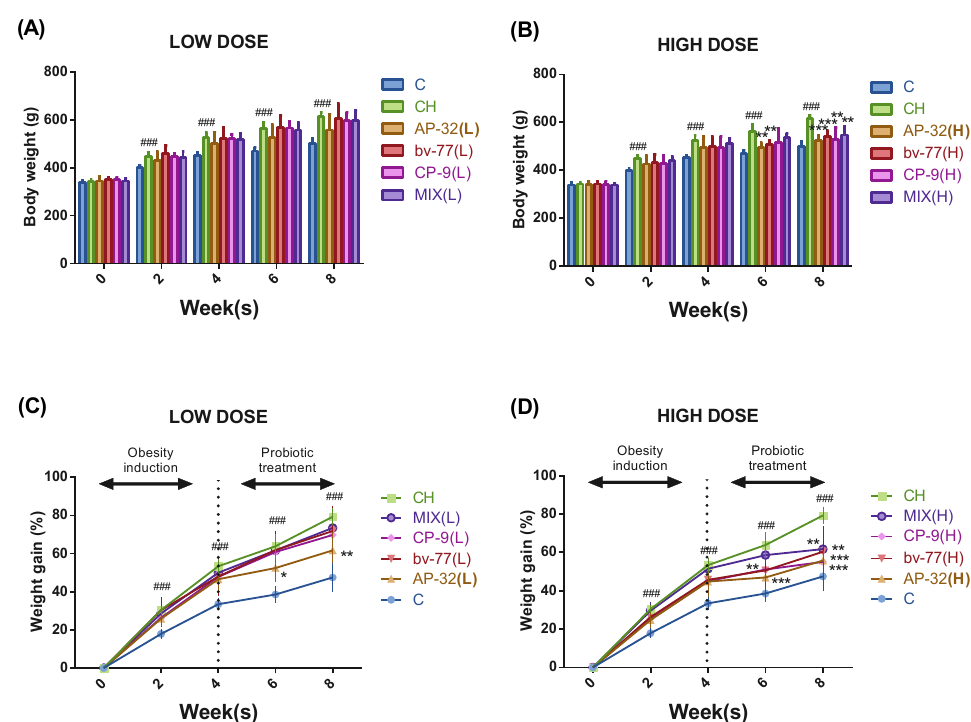
Figure 1. Body weights and weight gain rates in obese rats from week 0 to week 8. Sprague-Dawley (SD) rats were fed a high-fat diet to induce obese symptoms for 8 weeks. The probiotic groups were treated with a single strain (AP-32, bv-77, or CP-9) or a mixture of 3 strains (MIX) at a low (L = 5 × 10 9 CFU/kg/day) or high (H = 2.5 × 10 10 CFU/kg/day) dosage. The group of rats fed a normal diet was the blank control (C), and the one fed a high-fat diet was the symptom control (CH). The bar graph represents the body weights of rats treated with a ( A ) low dose and ( B ) high dose of a probiotic strain(s). The weight gain rate was normalized to the body weight at week 0, and presented as a percentage in rats treated with a ( C ) low dose and ( D ) high dose of a probiotic strain(s). The body weight was recorded every 2 weeks, and data show the mean ± S.D. of six animals in each group. The dotted line represents the beginning of the probiotic supplementation. Statistical analysis was performed by using a one-way ANOVA. Statistical difference was compared between the C and CH groups ( ### p < 0.005) or between the CH and a probiotics-treated group (* p < 0.05, ** p < 0.01, *** p < 0.005).